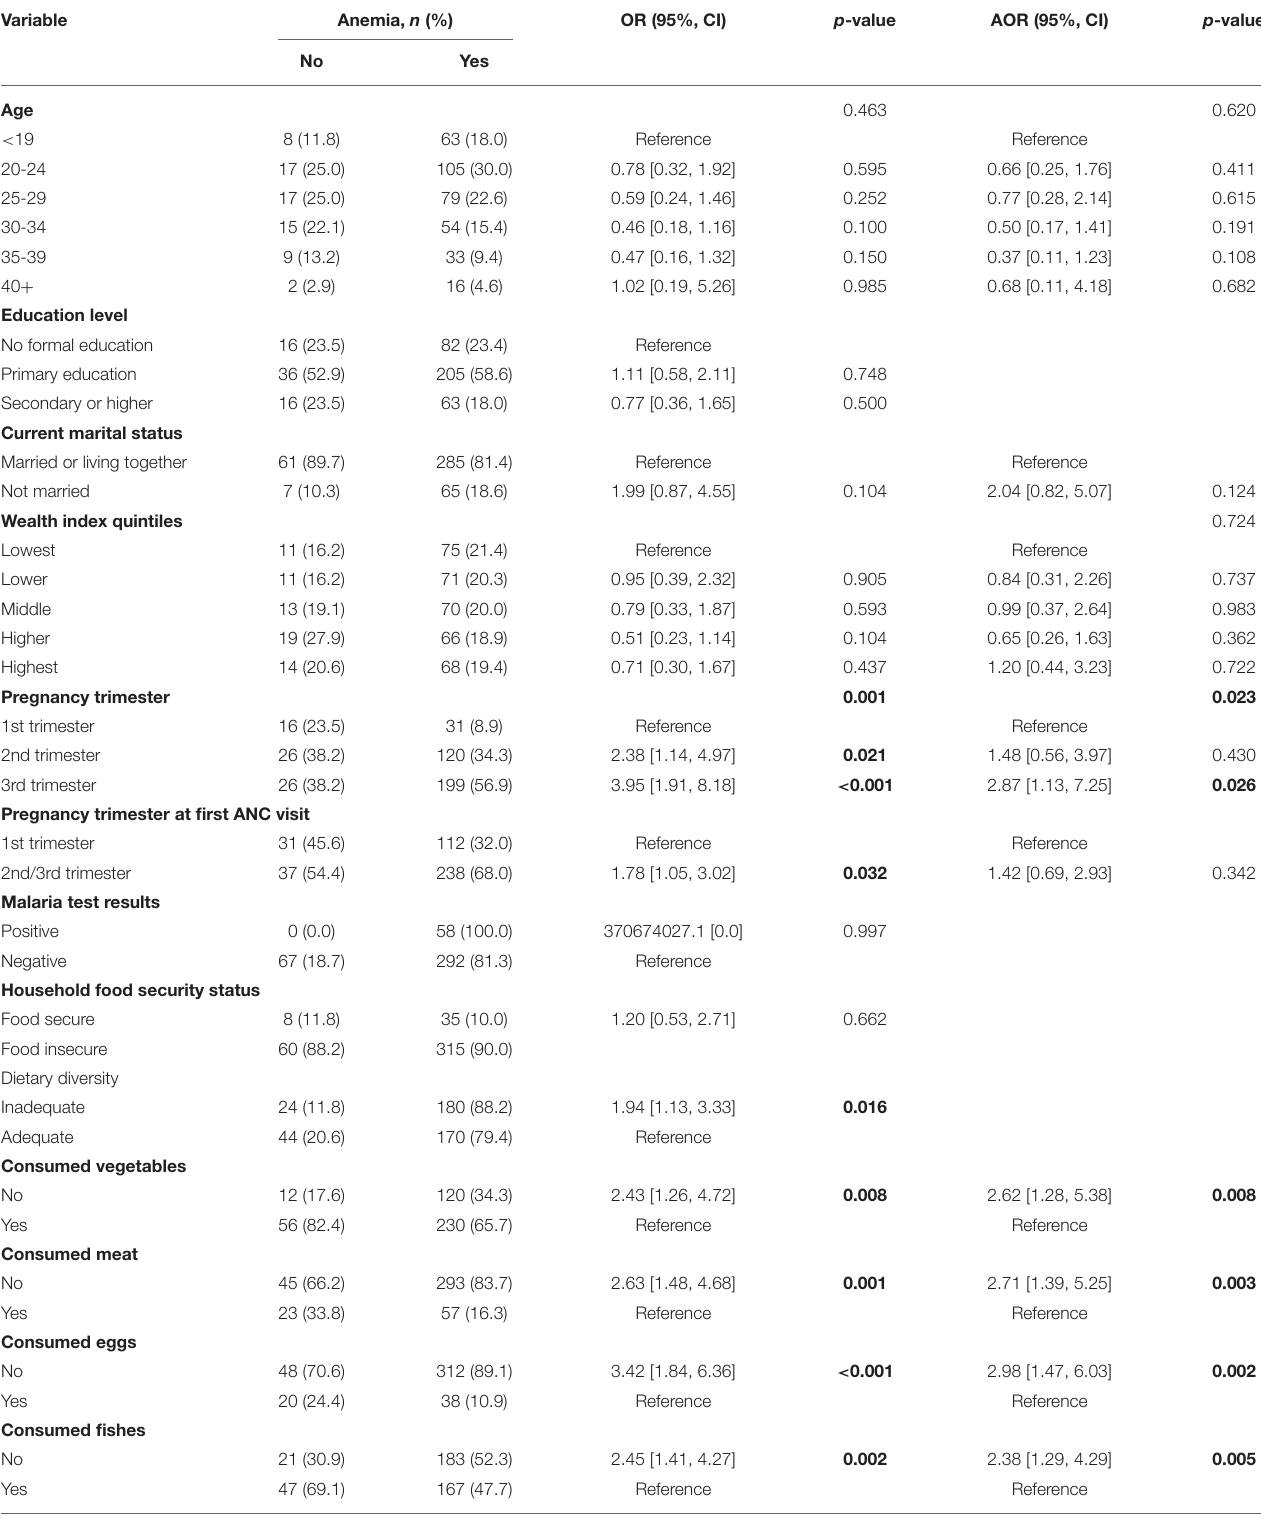
TABLE 2 | Bivariate and multivariate analysis of factors associated with anemia among pregnant women attending ANC in Mkuranga district hospital.